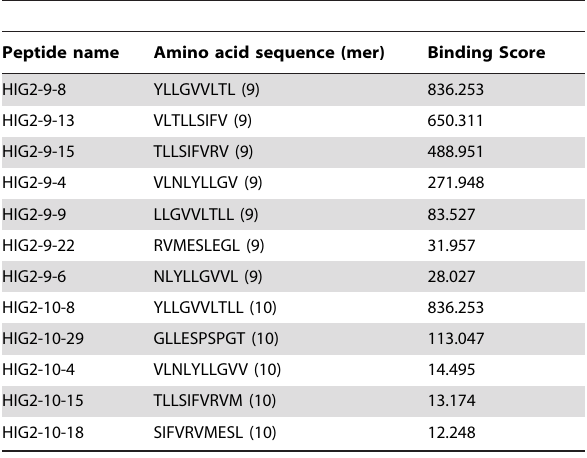
Table 1. Candidate peptides derived from HIG2 restricted with HLA-A*02:01.